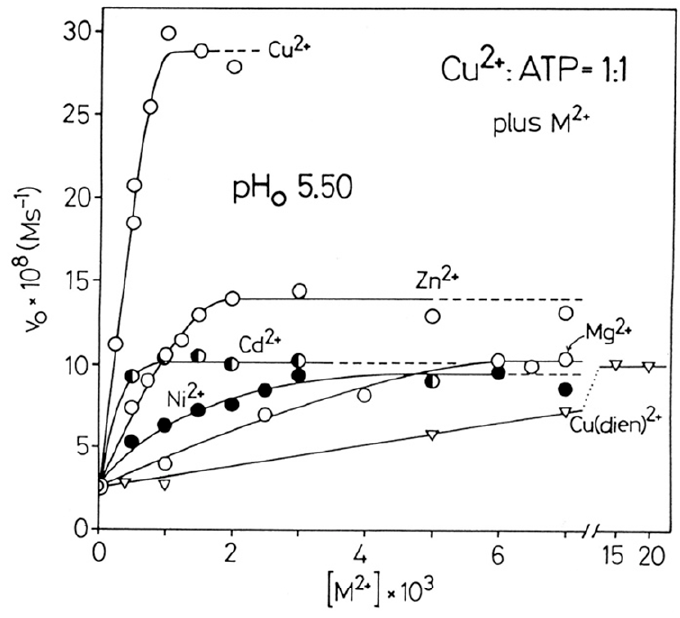
Figure 8. Dependence of the initial rate, v 0 = d[PO 4 ]/dt (M s − 1 ), of the Cu 2+ -promoted dephosphory- lation of ATP ([Cu 2+ ] tot = [ATP] tot = 10 − 3 M) in aqueous solution on the addition of further divalent metal ions (empty circles, half-filled circles, full circles) or the Cu 2+ 1:1 complex with diethylene- triamine (= dien = 1,4,7-triazaheptane ( ▽ )) at pH 0 5.50; I = 0.1 M, NaClO 4 ; 50 °C. The broken line portions indicate uncertainty due to precipitation. The figure is reproduced with permission from our publication in Inorganica Chimica Acta [55]; copyright 1992, Elsevier Sequoia (see also [14]). However, Mg 2+ , Ni 2+ , and Cd 2+ reach as the second metal ion and as promoters of the dephosphorylation reaction all a limiting v 0 value of about 10 · 10 − 8 M s − 1 —that is, compared